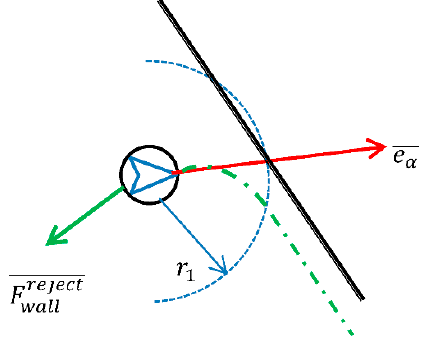
Figure 11. Repulsive force of a wall.